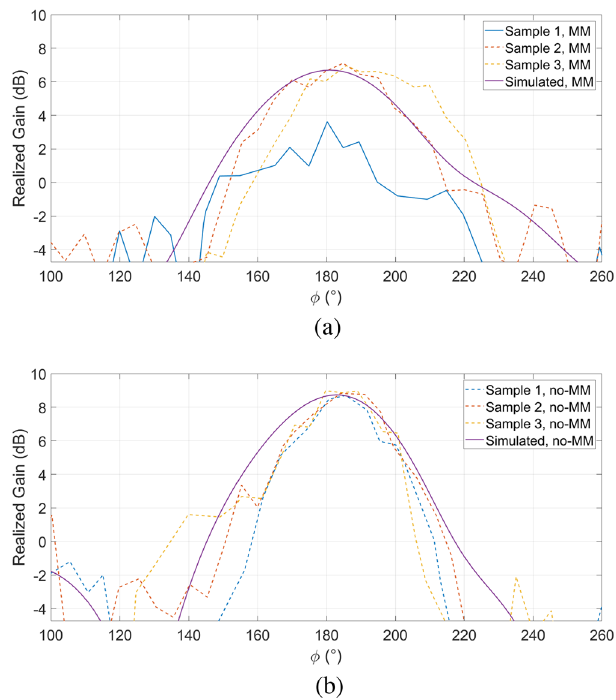
◦ ◦ and φ = 180 at 305 GHz of the non-MM-